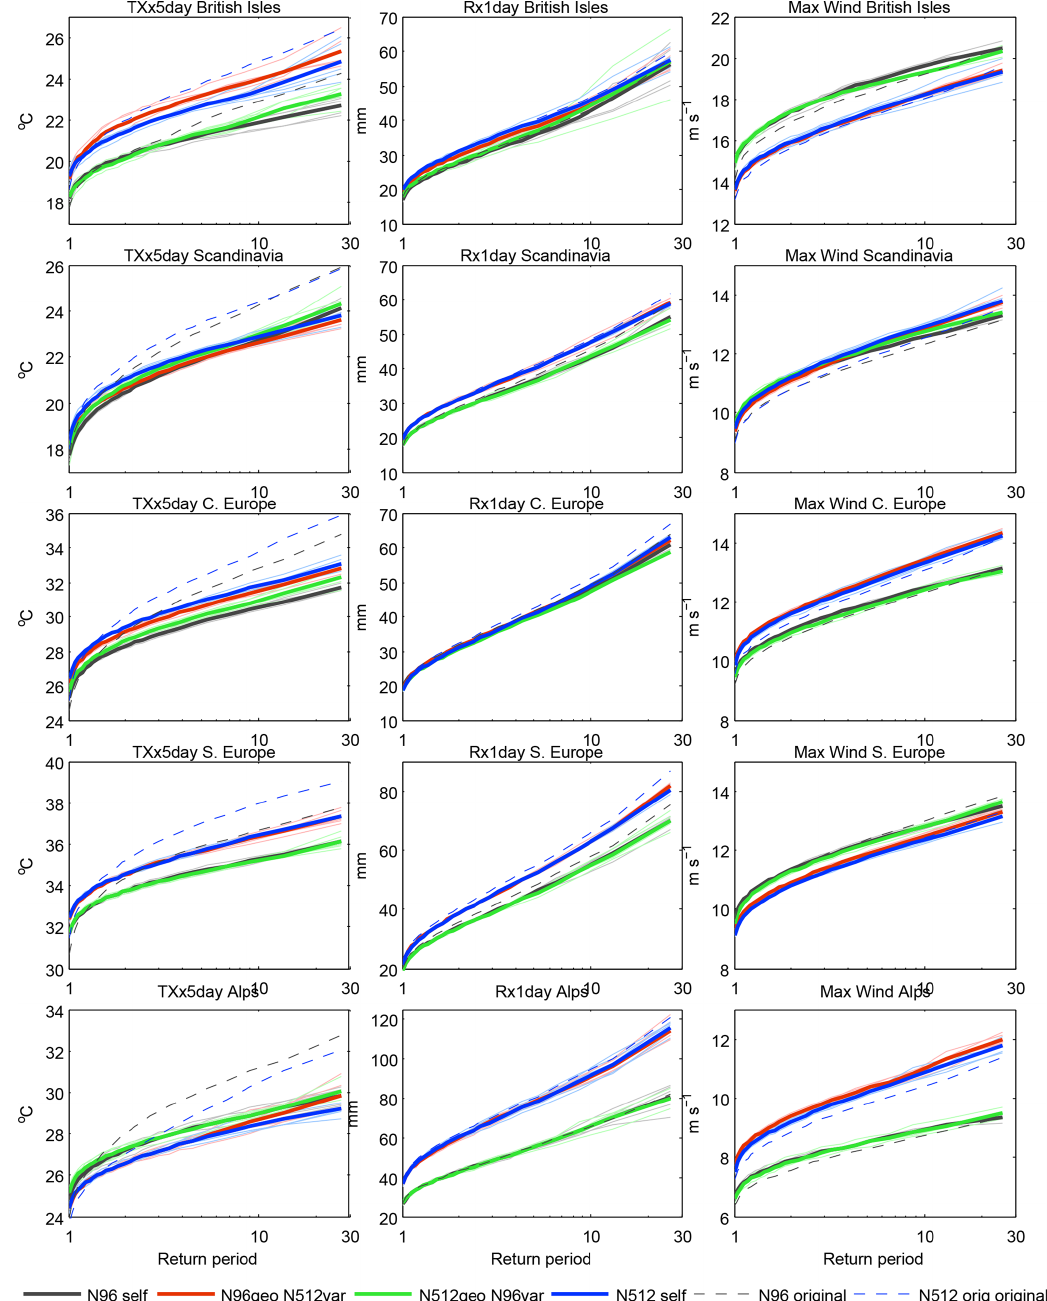
Figure 9. Circulation analogue results. Return period plots for (left) TXx5day, (middle) Rx1day, and (right) annual maximum wind for (top) the British Isles, (second row) Scandinavia, (third row) central Europe, (fourth row) southern Europe, and (fifth row) the Alps. Grey represents the N96 self-analogues and blue the N512 self-analogues; red is for N96 circulation with N512 variables (e.g. precipitation), and green is for N512 circulation with N96 variables. Thin lines represent individual ensemble members, and thick lines represent the mean across individual ensemble members. The blue dashed line represents the original N512 ensemble mean results like those shown in Fig. 6 (although sometimes based on a different time period), and the grey dashed lines represent the equivalent for the N96 simulations. Results for TXx5day are based on the period 1985–2011, Rx1day 1986–2011, and wind